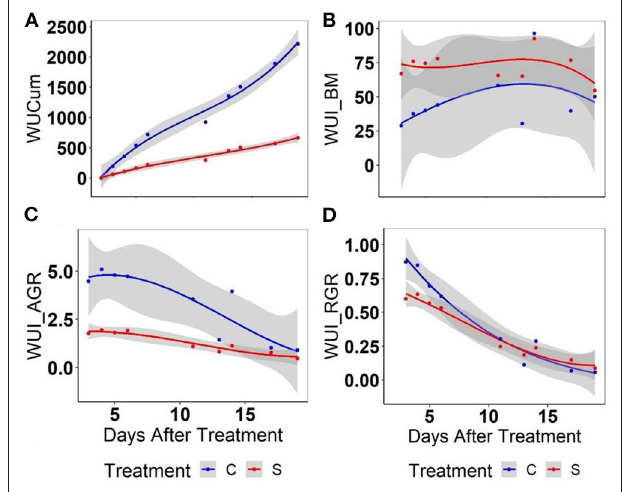
FIGURE 7 | Assessment of different parameters for water use using mungbean plants: (A) cumulative water use (WUCum), (B) a biomass-based water-use index (WU_BM), (C) an AGR-based water-use index, and (D) a RGR-based water-use index in well-watered (C) and water-stressed (S) plants: WUCum represents the cumulative water use in ml plant − 1 at any given point of growth while WUI_BM computed as the predicted biomass mg ml − 1 water, WUI_AGR or WUI_RGR was computed for per unit of water as given in Material and Methods. Solid lines represent the means of all genotypes while the shaded part indicates the CI at